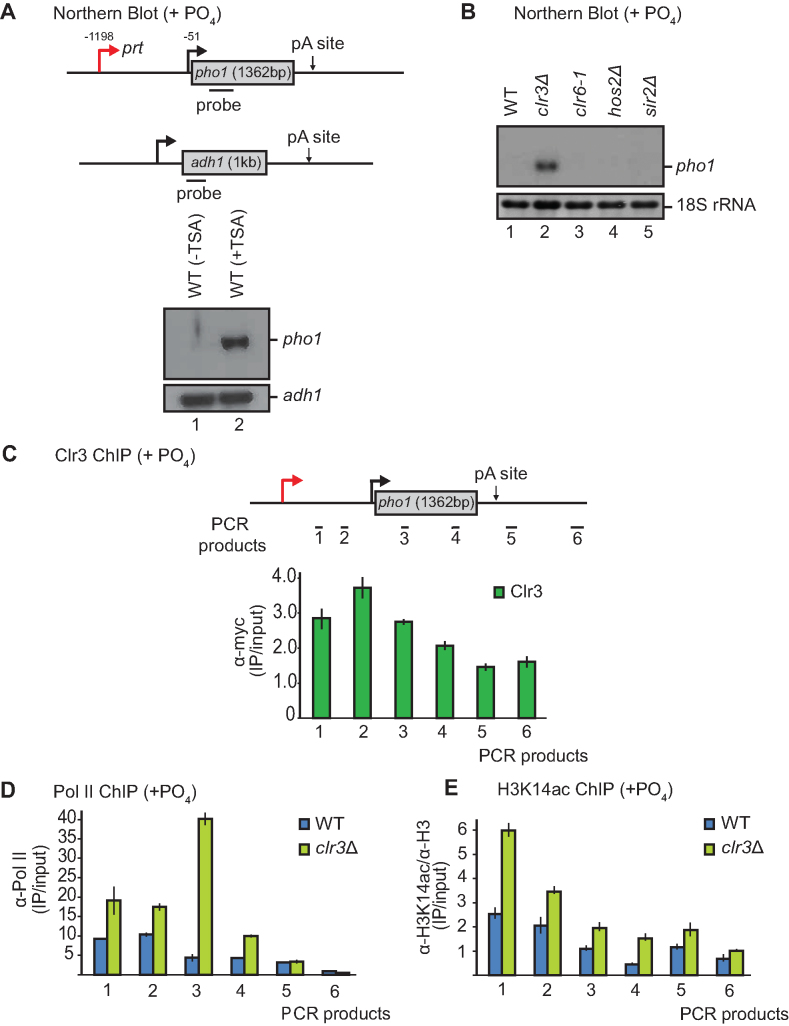
The HDAC Clr3 contributes to pho1 silencing. (A) Schematic of pho1 (top) and adh1 (bottom) genes are shown with probes indicated by black bars. Northern blot analysis of RNA isolated from a wild-type (WT) strain untreated (–TSA) or treated (+TSA) with 20 μg/mL of the HDAC inhibitor trichostatin A (TSA). The housekeeping gene adh1 serves as loading control. (B) Northern blot analysis of RNA isolated from the indicated strains grown in YES. 18S ribosomal RNA serves as a loading control. (C) Schematic of pho1 gene with qPCR products indicated by black bars. Clr3-myc ChIP was performed in YES. (D) Pol II and (E) H3K14ac ChIP analysis performed in a clr3Δ strain compared to wild-type (WT) levels. In all ChIP-qPCR figures the mean from three independent experiments is shown; error bars indicate the standard error of the mean.